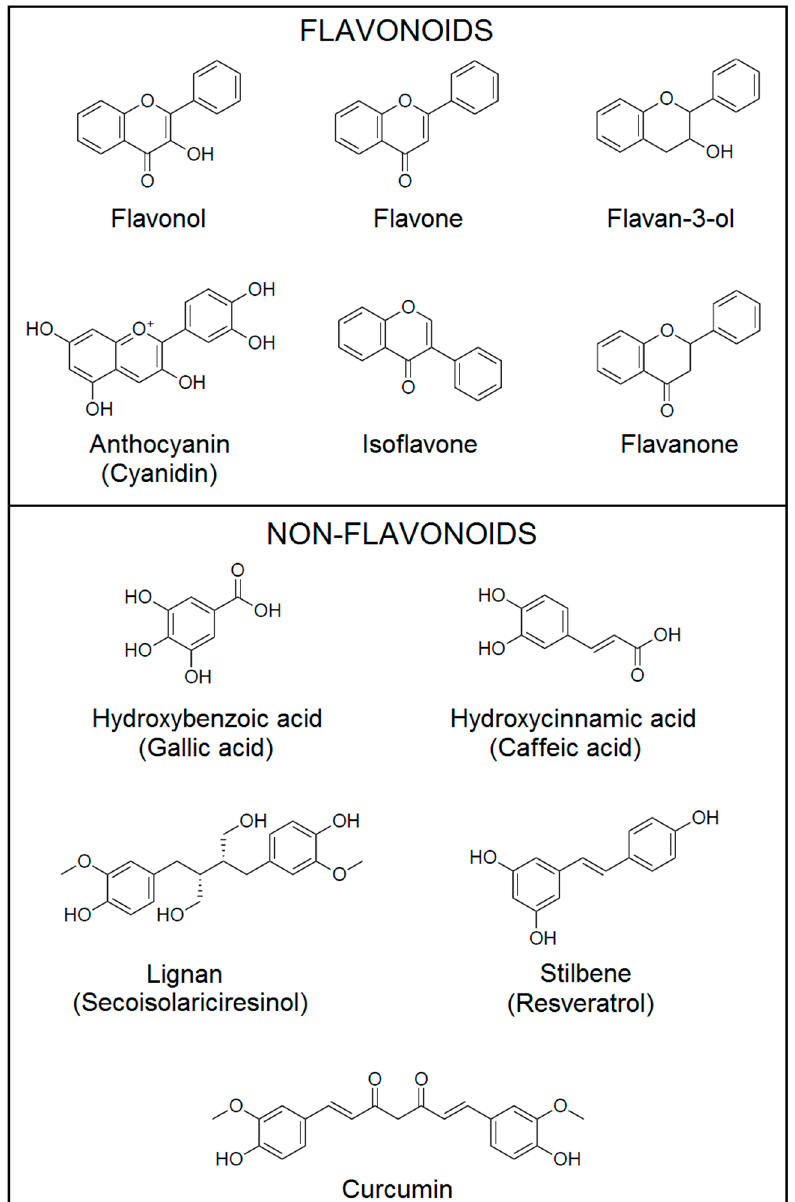
Figure 1. Chemical structures of polyphenols. Dietary polyphenols can be classified by their chemical structures into flavonoids and non-flavonoids. Structures generated using ChemDraw JS 17.1 (CambridgeSoft Corp., Cambridge, MA, USA).